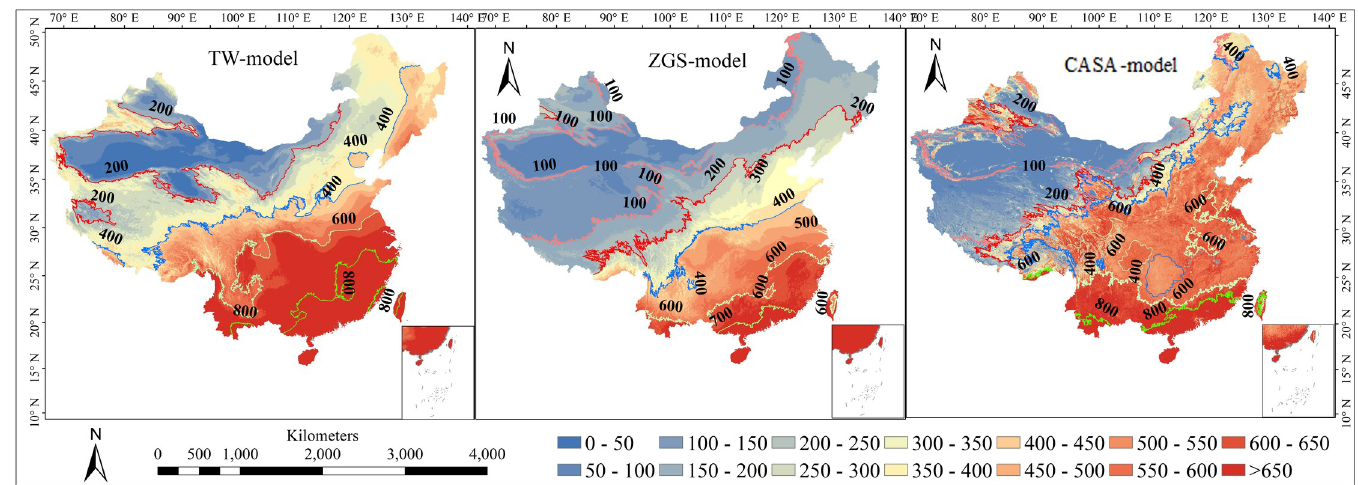
Fig 5. The spatial pattern of NPP calculated by three models (Abbreviation: TW represents Thornthwaite Memorial model, ZGS represents the synthetic model).